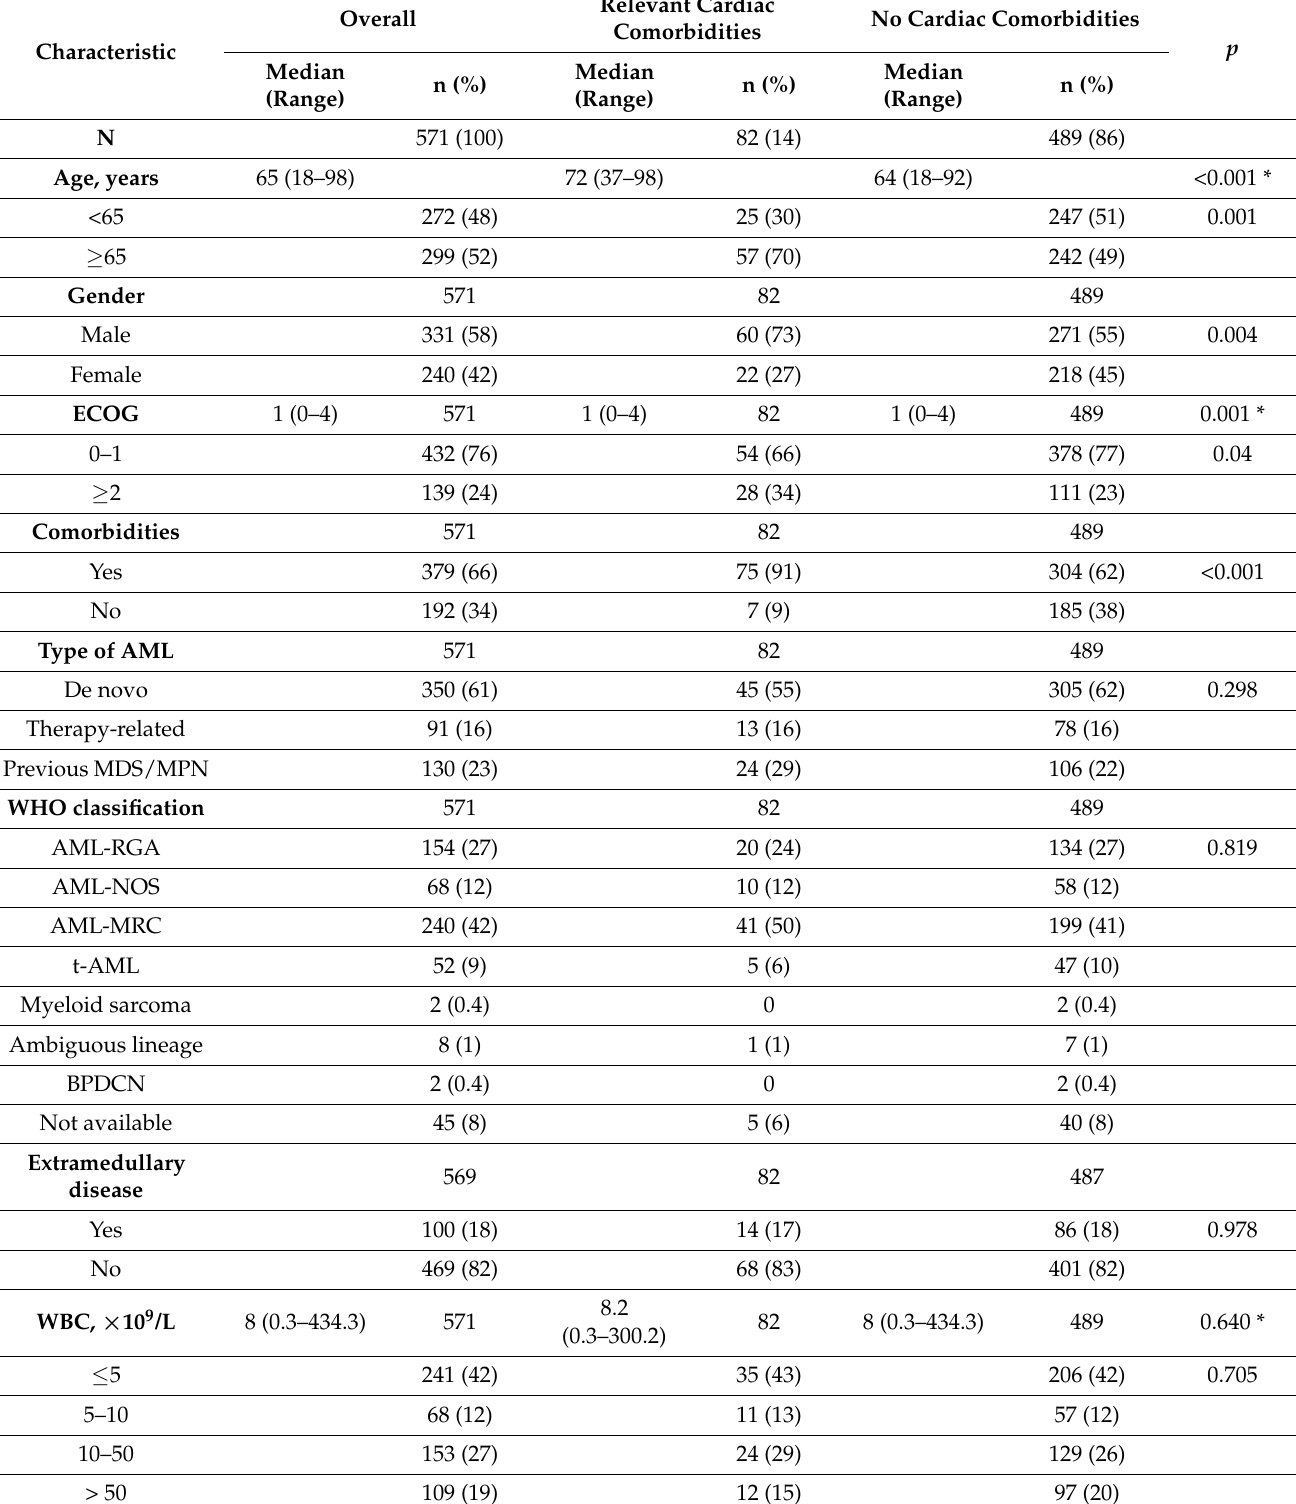
Table 2. Demographic, clinical, and biological characteristics of patients at diagnosis according to previous cardiac